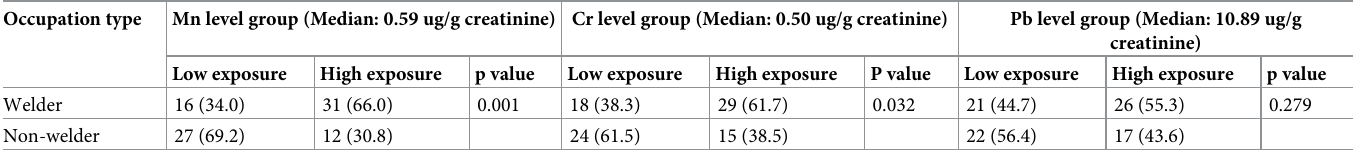
Table 2. Comparison of urine metals (Mn, Cr, and Pb) between occupation types and metal groups.